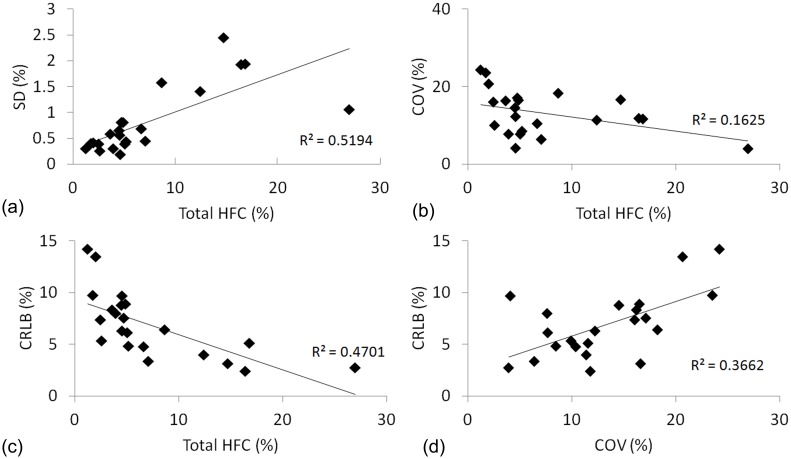
Scatter plot and regression line between (a) total HFC and SD, (b) total HFC and COV, (c) total HFC and CRLB and (d) COV and CRLB for 22 subjects.